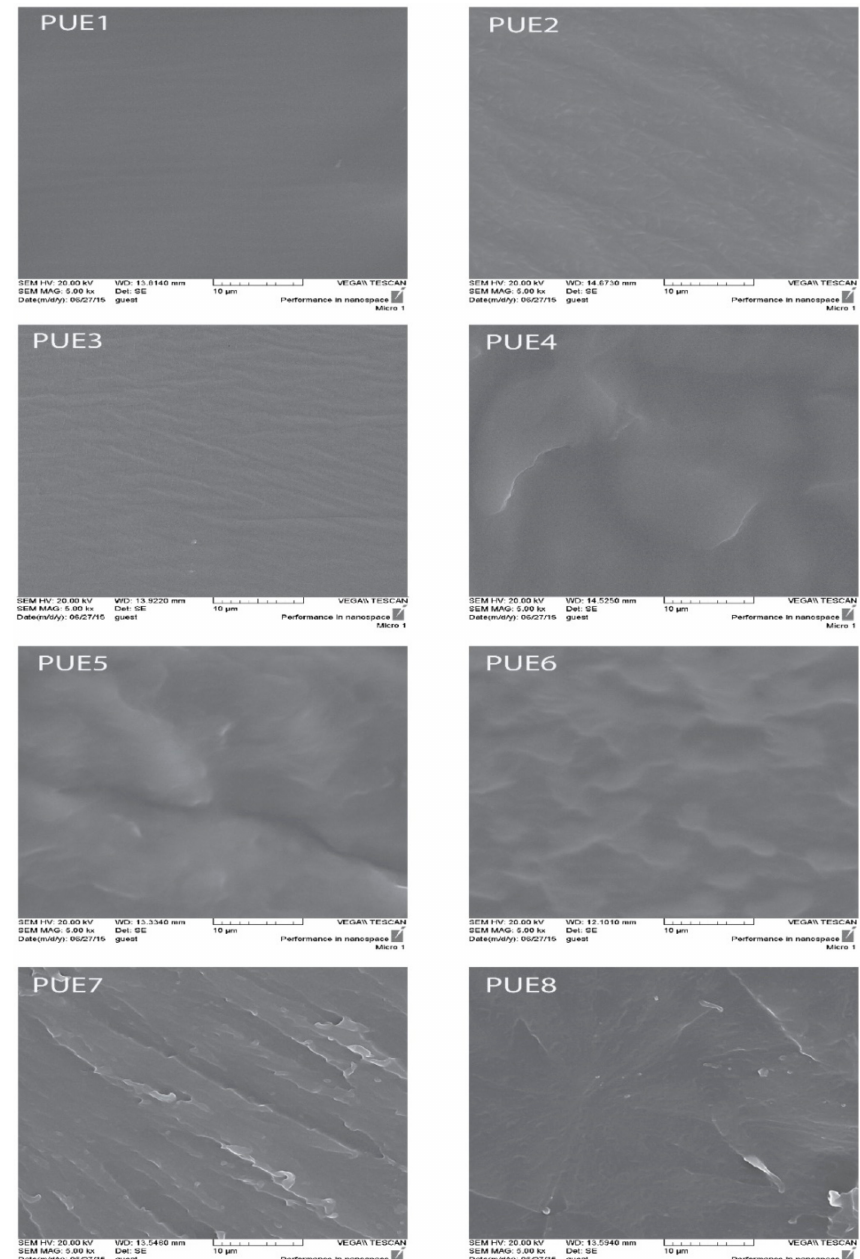
Figure 4. Scanning electron images (SEM) of polyurethane